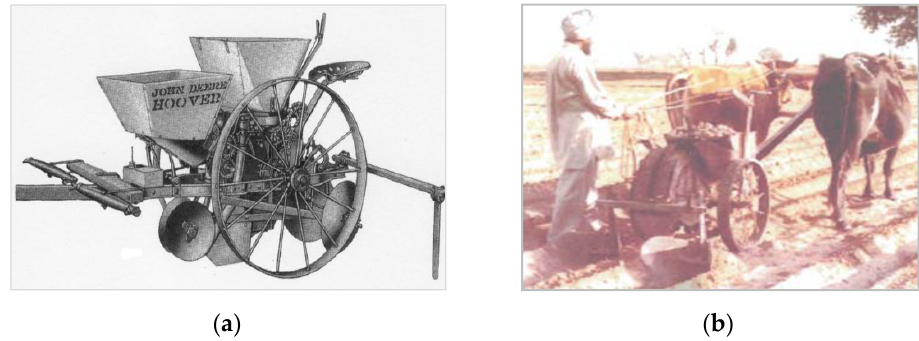
Figure 13. Animal-powered potato planters. ( a ) John Deere. Reprinted with permission from ref. [45]. Copyright 2008 Central Potato Research Institute; ( b ) animal drawn. Reprinted with permission from ref. [45] . Copyright 2008 Central Potato Research Institute.